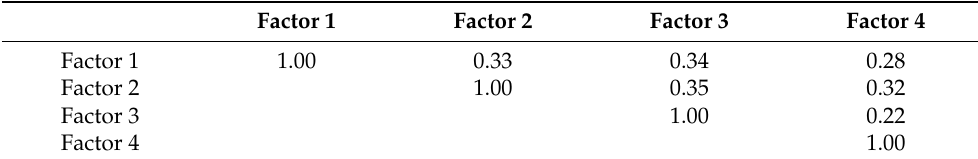
Table 2. Correlation matrix of all factors after conducting oblimin